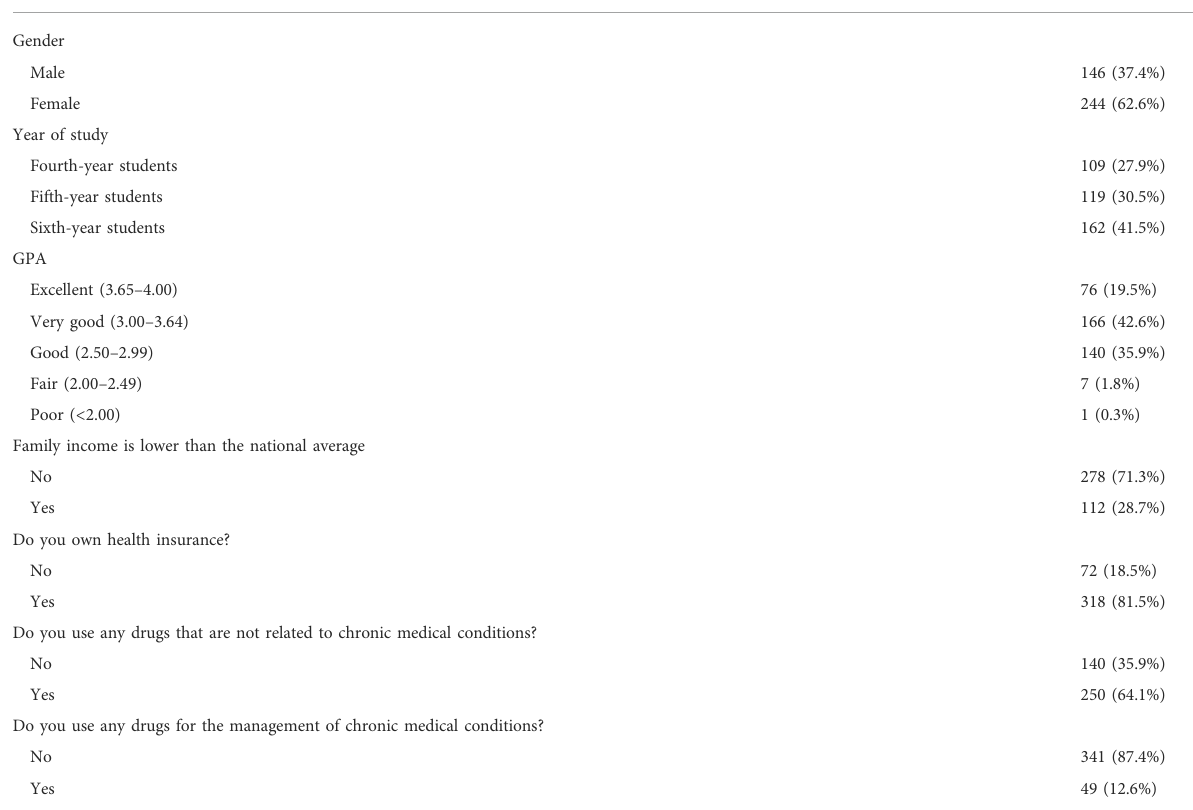
TABLE 1 General characteristics of the participants, N =